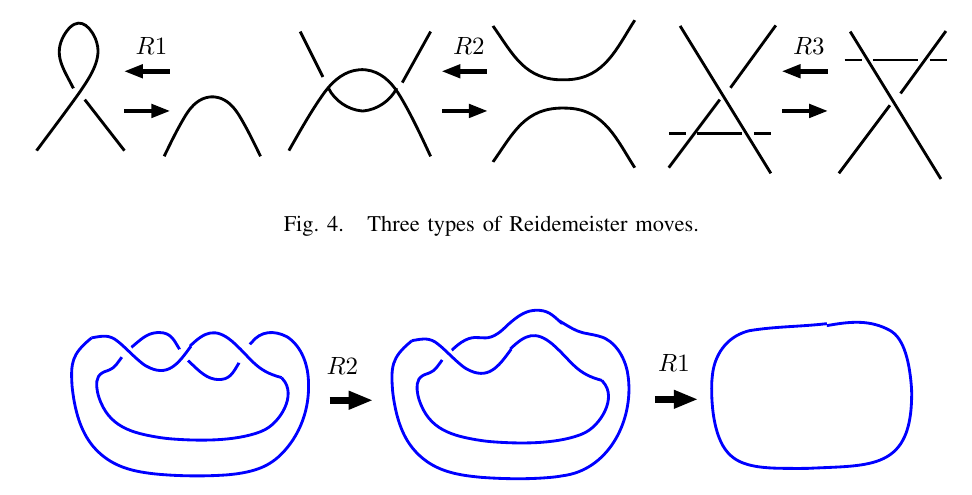
Fig. 5. The left diagram is deformed into the right by R 2 . The middle diagram is deformed into the very right by R 1